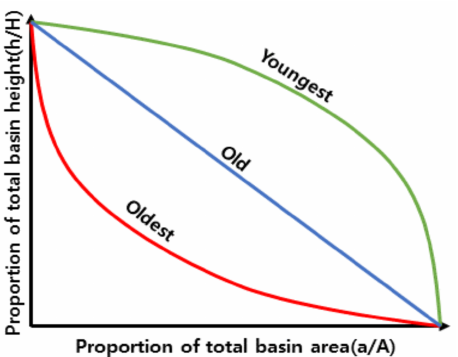
Figure 6. Interpretation of Hypsometric Curve. HC is divided into the youthful, mature, and old